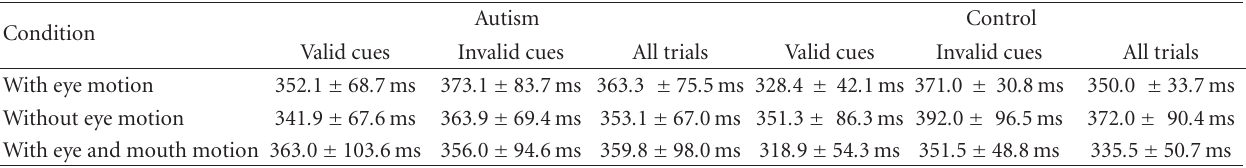
Table 4: Mean reaction times for the autism and control groups for each condition. Values are in milliseconds ( ± SD). Autism Control Condition Invalid cues All